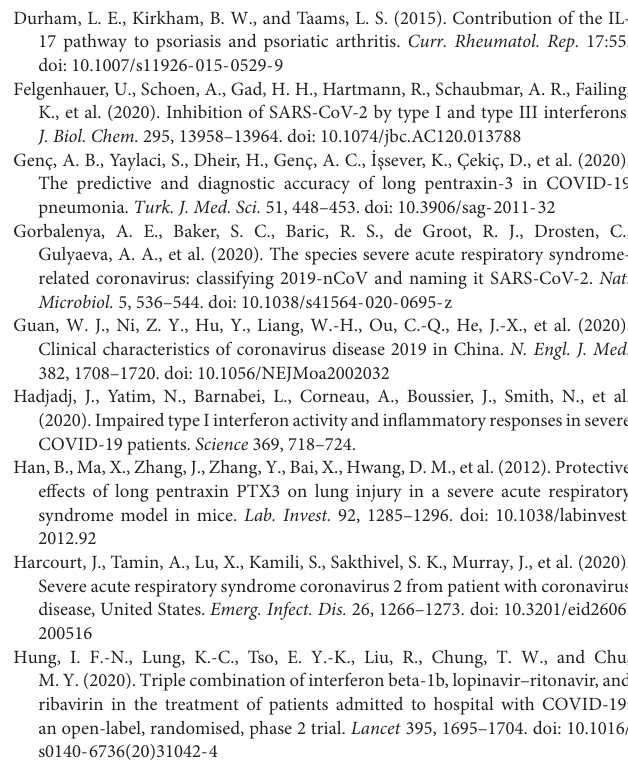
Supplementary Table 3 | Top 10 GO-terms for each group. Supplementary Table 4 | Correspondence of co-expressed genes and modules. Supplementary Table 5 | TPM matrix from 126 clinical patients of 79 infection-related genes. Supplementary Table 6 | Phased WGCNA Results of Vero E6. Supplementary Table 7 | Phased WGCNA Results of